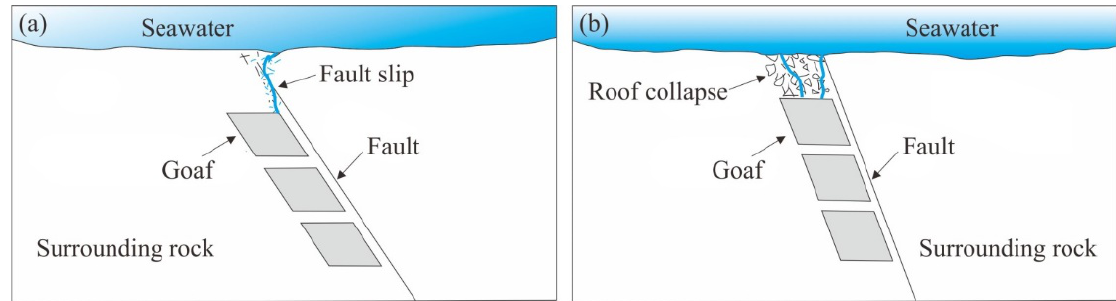
Figure 13. Potential penetrative failure modes . ( a ) fault slip; ( b ) roof collapse.